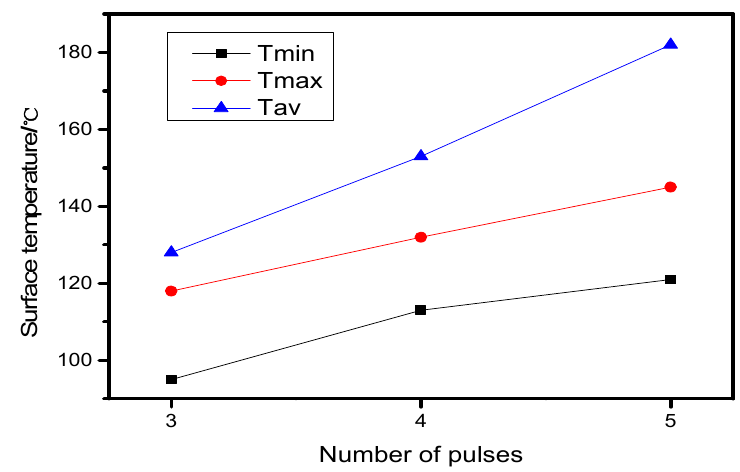
Figure 12. Comparison of the sample surface temperature under different pulse numbers.